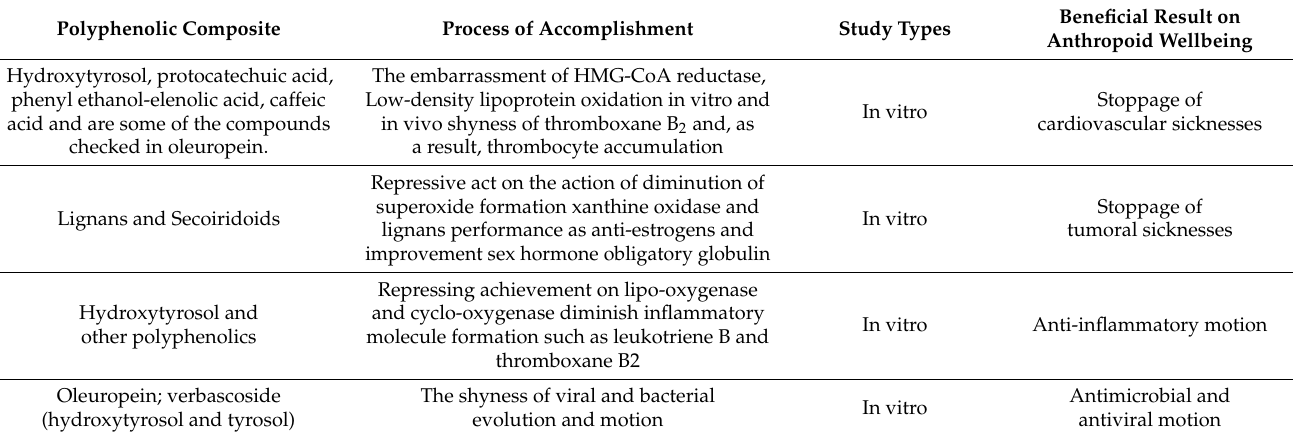
Table 7. Biological properties of olive oil phenolics